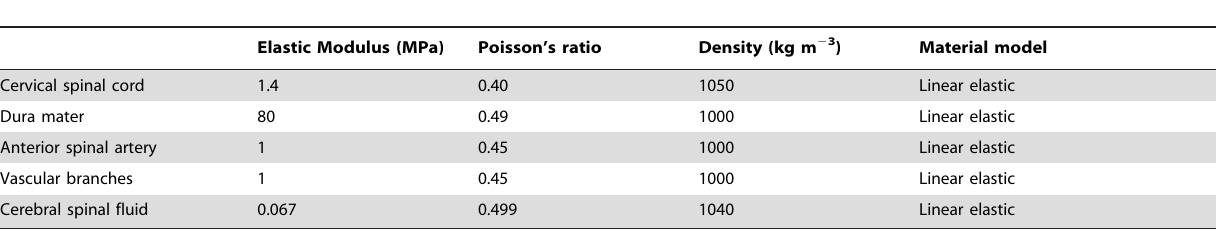
Table 1. Material models and parameters used to simulate cervical spinal cord compression.